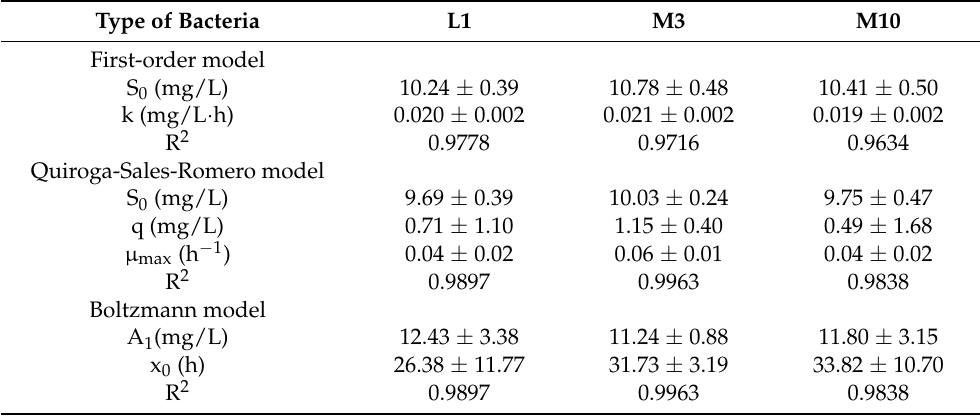
Table 2. The kinetic parameters corresponding to the degradation curve by pure strains at 10